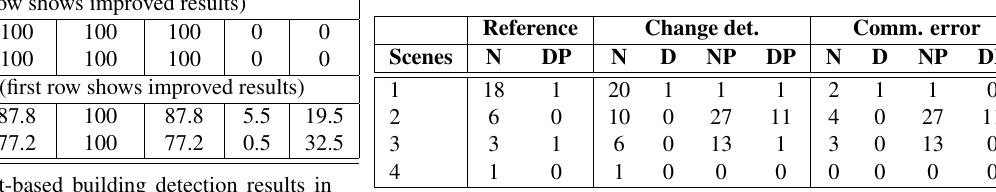
Table 5: Change detection results with removal of commission errors > 25 m 2 in area . N = new buildings, D = demolished buildings, NP = new building parts and DP = demolished building parts.